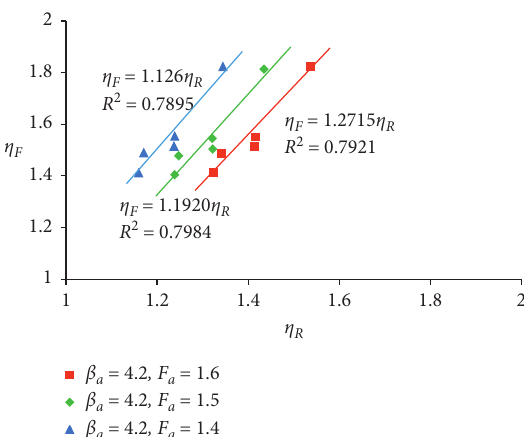
Figure 9: The correlation of η slopes).